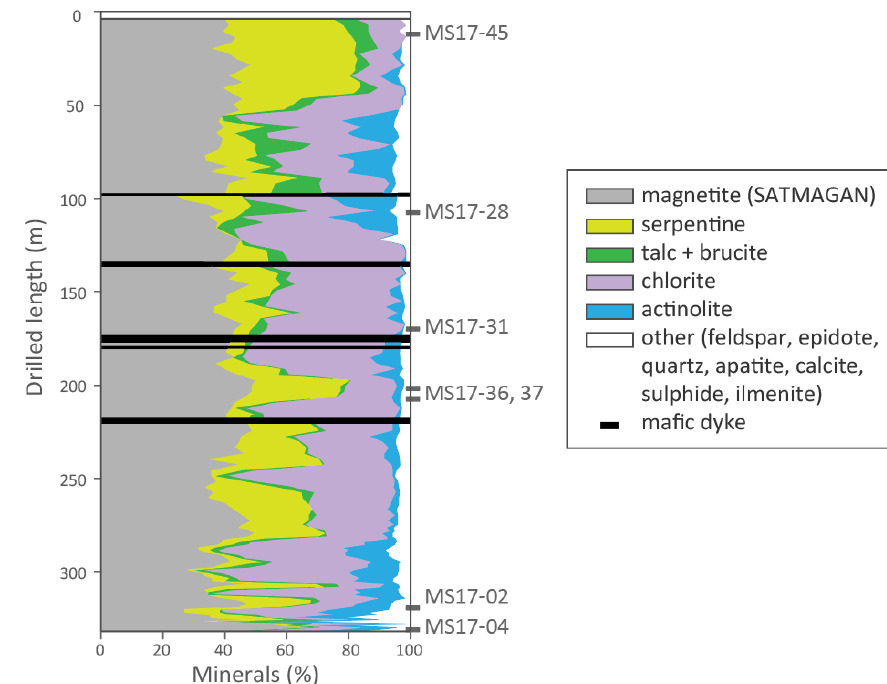
Figure 3. Minerals represented as a function of downhole length (drill hole MS-13-17). Magnetite proportions measured by SATMAGAN [20] and normative greenschist facies minerals calculated with the CONSONORM_LG method [33] are represented. The samples considered by this study are designated as MS17-xx (see also Supplemental Material S1). The mafic dykes correspond to thin-grained intervals with sharp contacts. Mineral abbreviations are as reported in the literature [34].